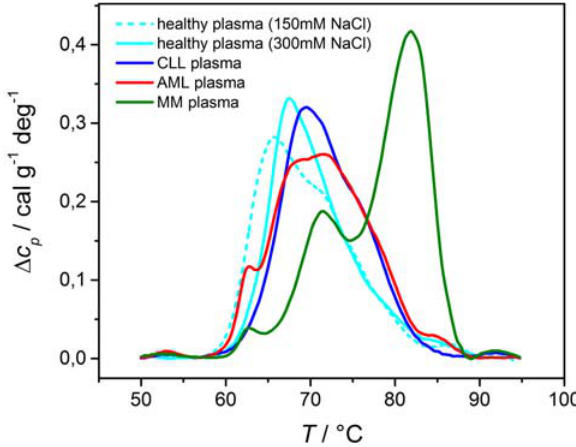
Figure 1. Comparison of thermograms of blood plasma from disea- sed individuals dissolved in 20 mM phosphate buffer and 300 mM NaCl and with a thermogram of blood plasma from healthy indivi- dual dissolved in 10 mM phosphate buffer and 150 mM NaCl (das- hed cyan line) and 20 mM phosphate buffer and 300 mM NaCl (full cyan line).